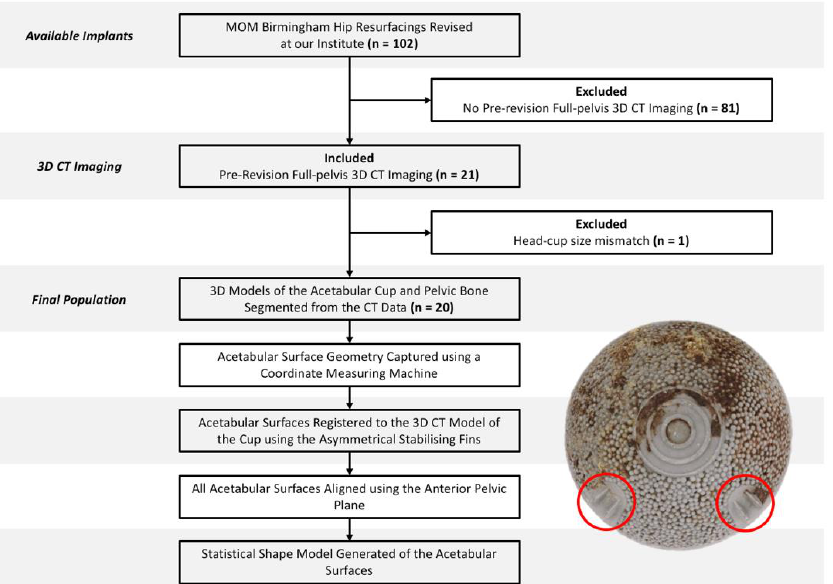
Figure 1. Study design and workflow, accompanied by the backside surface of a Birmingham acetabular component and its asymmetrical stabilising fins (circled in red).